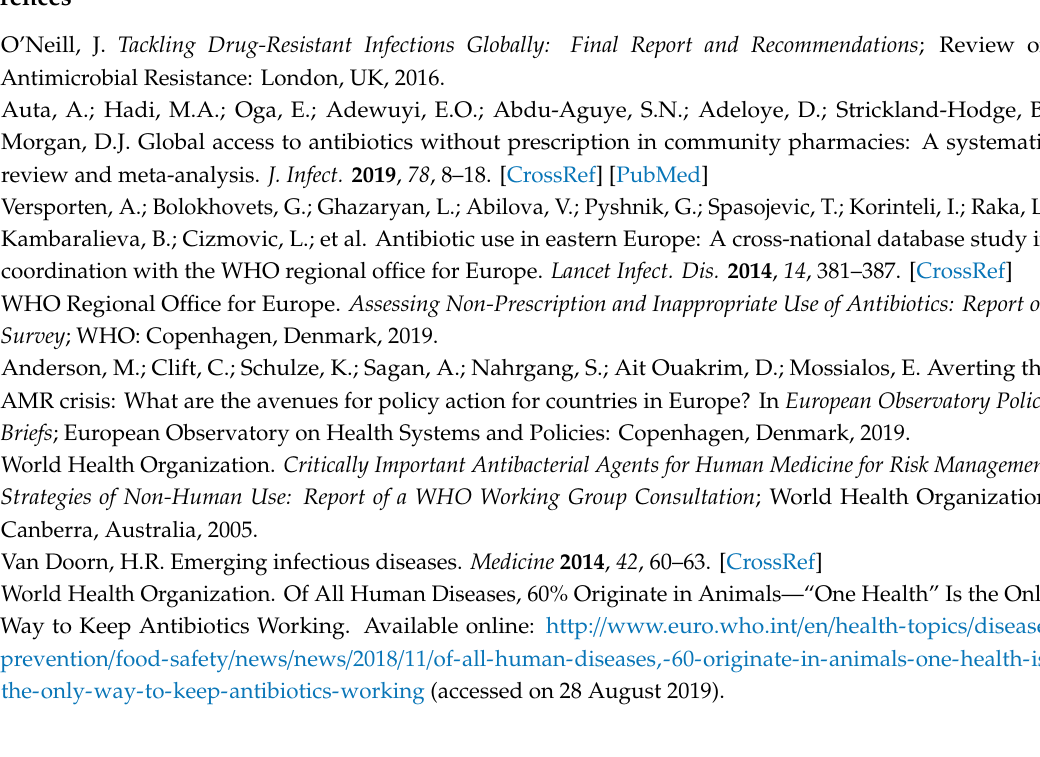
Table S1: Plot characteristics and soil properties of all 300 experimental plots, Table S2: ∆ Ct values of all analyzed target sequences in the 300 experimental plots, Table S3: Preliminary binomial (A) or tobit regression models